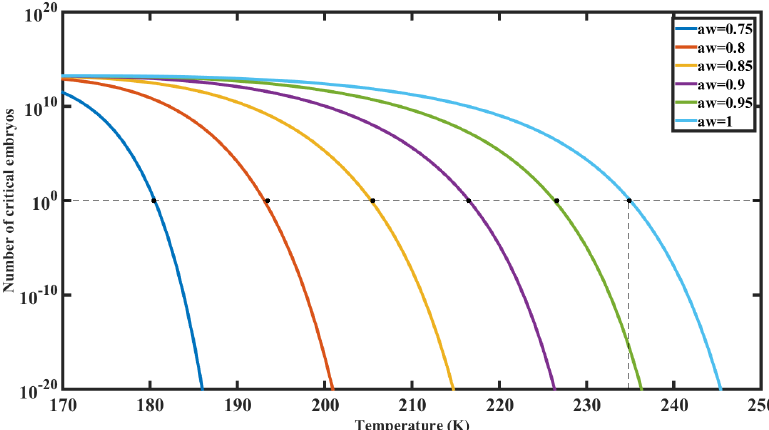
Figure 3. Mean number of critical embryos N c_mean (by Eq. 1) in a solution droplet (diameter = 10µm) with different water activity as a (V,a w ) derived by Eq. (2) (using σ i / w , e from TIP4P model). function of temperature. Solid circle: the approximations T N c = 1